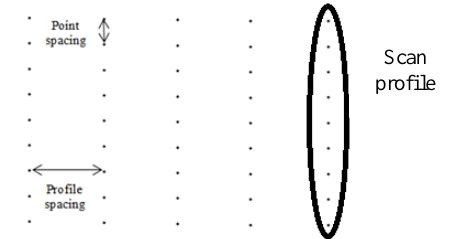
Figure 1. Scan profiles patterns of type 1